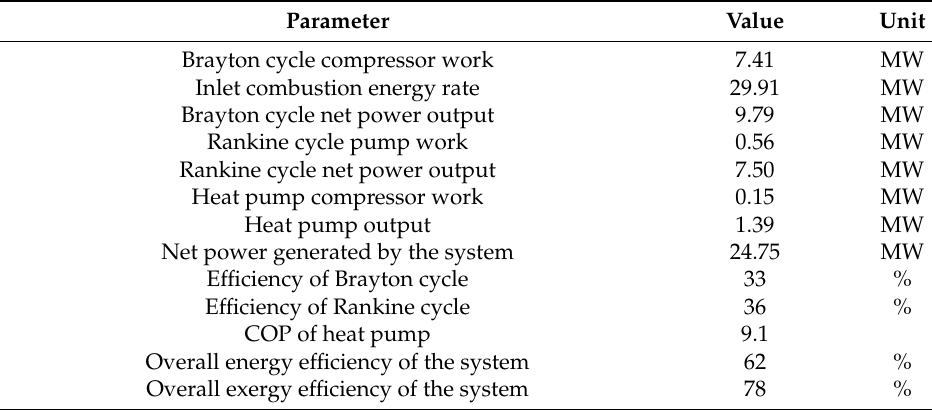
Table 3. Results obtained from the